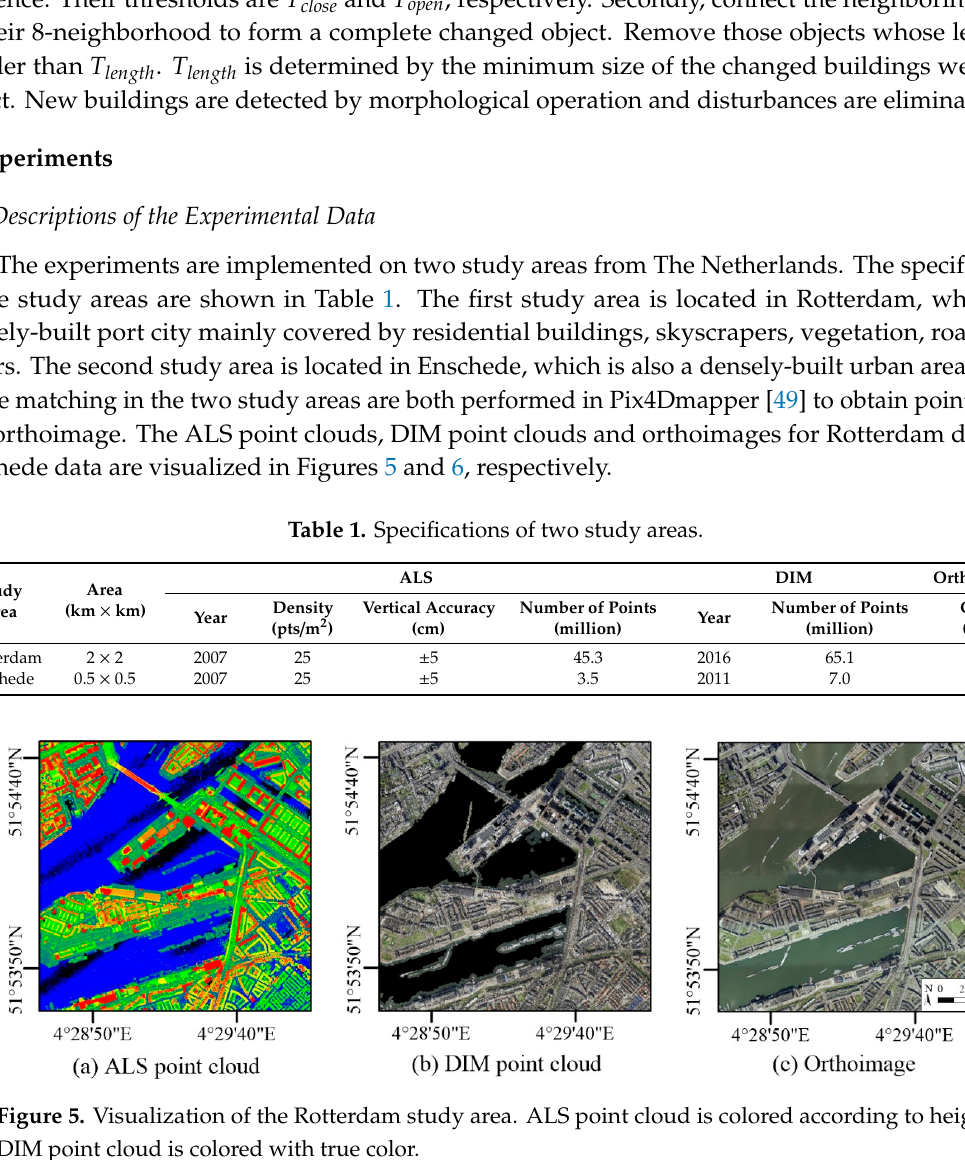
Figure 6. Visualization of the Enschede study area. ALS point cloud is colored according to height. DIM point cloud is colored with true color. The ALS and DIM data should be registered under the unique coordinate system beforehand. The ALS point cloud was provided under the Dutch national coordinate system (Amersfoort-RD New). The GCP coordinates used in the bundle adjustment were also in the same coordinate system, so the generated DIM point cloud was under the same coordinate system, which guarantees the registration between ALS data and DIM data.